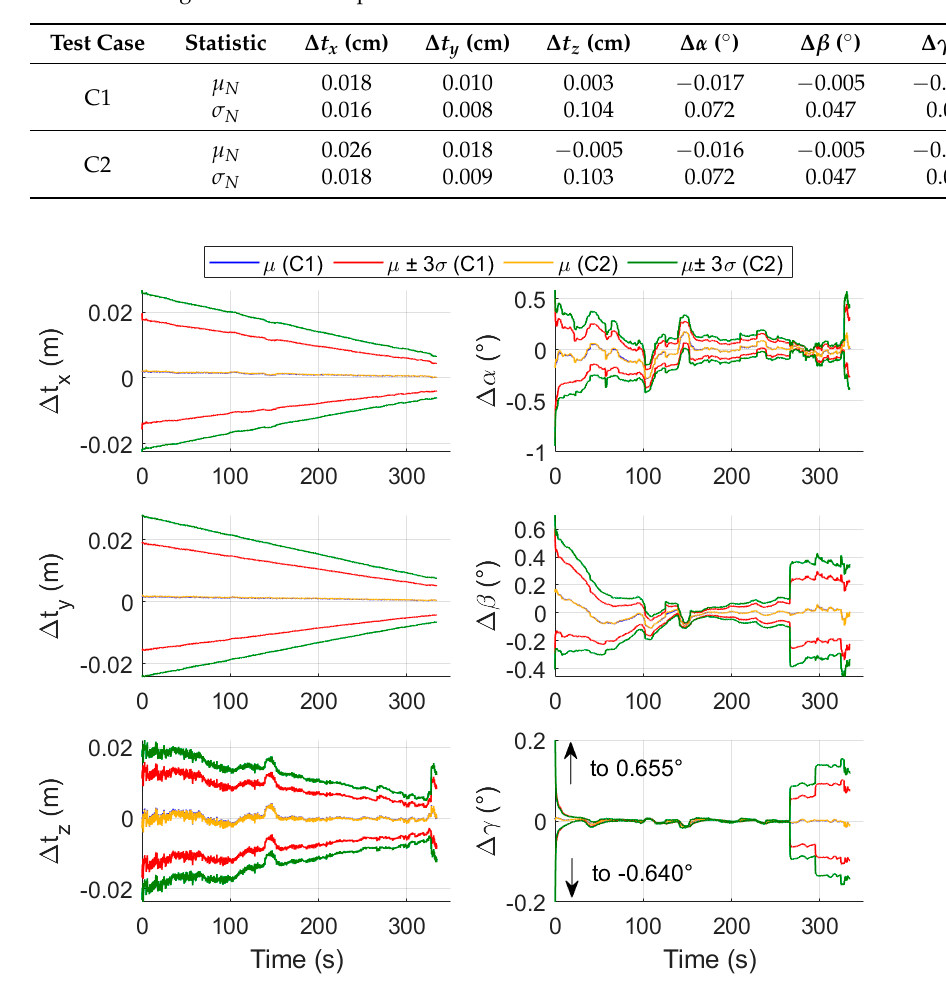
Figure 18. Temporal evolution of the mean of the errors on the pose parameters, with representation of the 3 σ intervals, for tests C1 and C2. The plots are focused on intervals about the mean values: the arrows indicate the maximum values reached by the pose initial guess at scenario start.